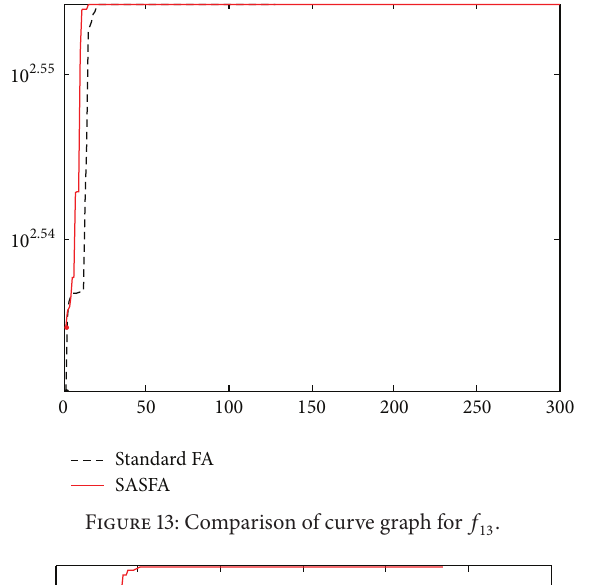
Figure 16: Comparison of curve graph for 𝑓 16